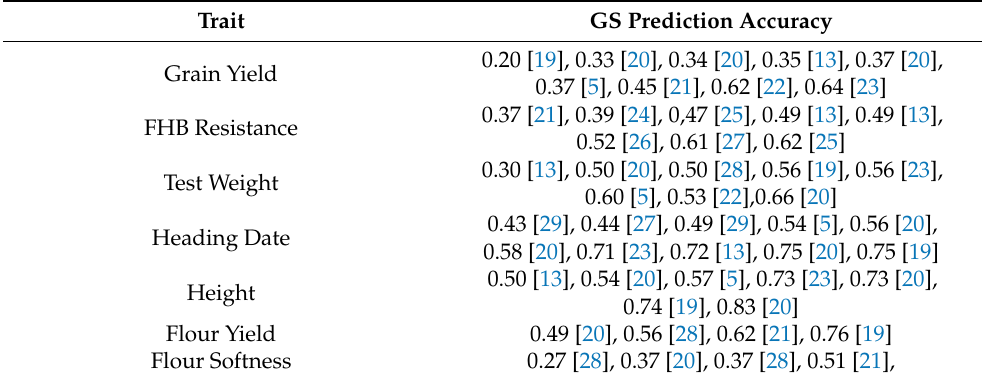
Table 4. Prediction accuracy of genomic selection for key soft red winter wheat traits. These values were obtained by cross-validation within defined training populations. The superscripts identify the associated